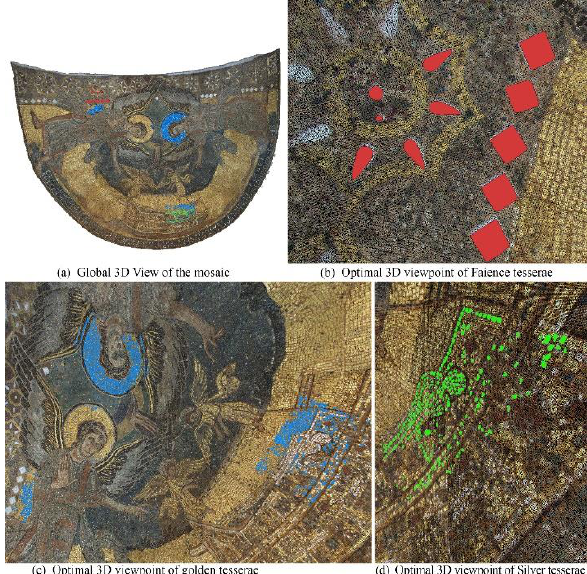
Figure 13 Global 3D view of the mosaic (a) and the optimal viewpoints for the faience, golden and silver